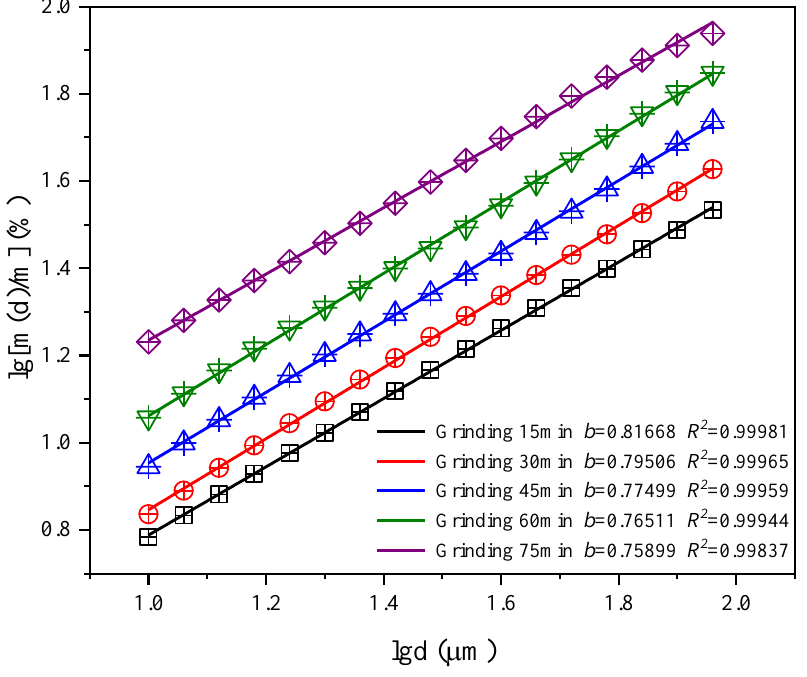
Figure 8. lg[m( d )/m] − lg d curves.